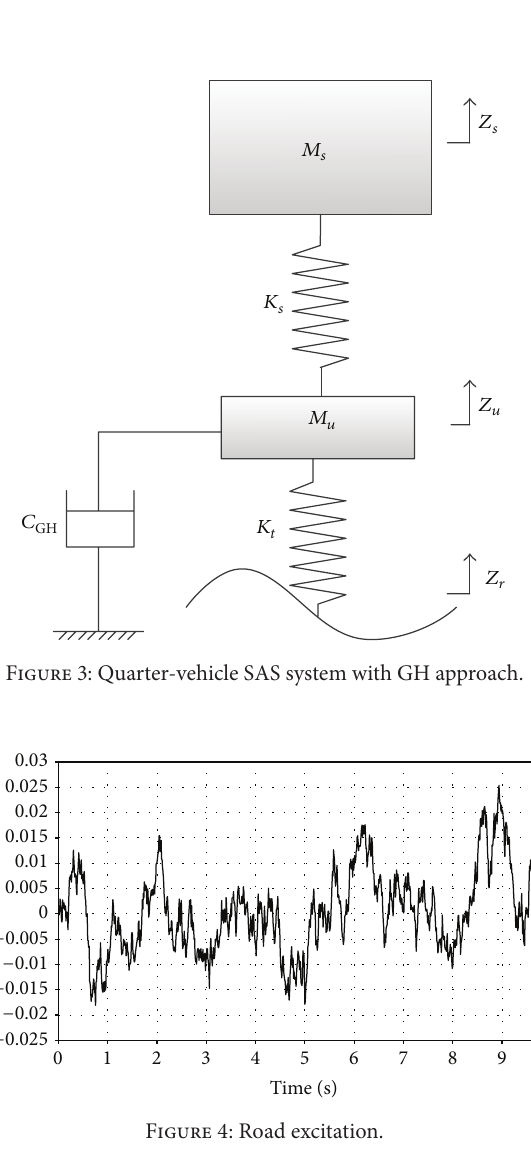
the unsprung mass and displacement of the sprung mass, respectively.